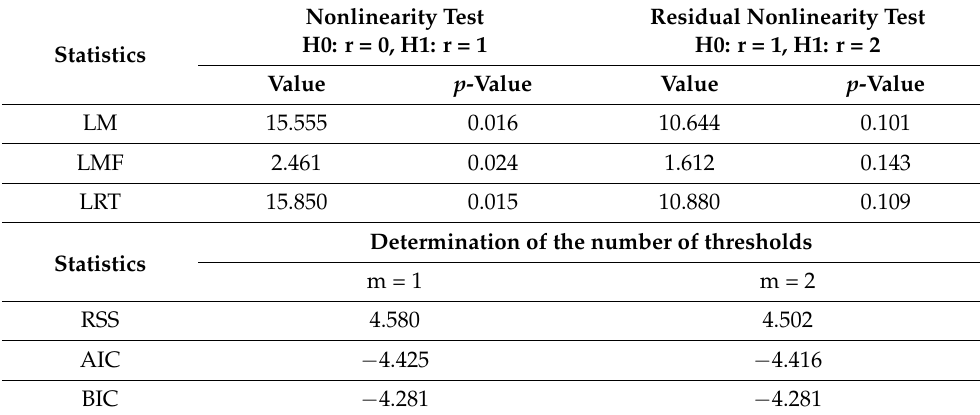
Table 2. Nonlinearity test, residual nonlinearity test, and determination of the number of thresholds.